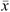
Two color-PALM imaging of ZapA-FtsZ, ZapB-FtsZ and ZapA-ZapA pairs.Cropped PALM images of cells expressing Dronpa-ZapA and FtsZ-PAmCherry1 (Ai-vi), ZapB-Dronpa and FtsZ-PAmCherry1 (Bi-vi), or Dronpa-ZapA and PAmCherry1-ZapA (Ci-v). Approximate cell outlines are indicated in yellow dashed lines. (Cvi) 2C-PALM image of a 100 nm TetraSpeck bead. (D) Histograms of the apparent displacement between the given protein pairs in individual cells. The mean values for the ZapA-FtsZ, ZapB-FtsZ and ZapA-ZapA pairs are 55 ± 50 nm (n = 158), 97 ± 70 nm (n = 132) and 33 ± 33 nm (n = 39), respectively (x- ± sd). (E) The diameters for ZapB-Dronpa and FtsZ-PAmCherry1 structures visualized simultaneously in the same cell (blue circles) were best fit to a line (red) where y = 1.0x - 95. The R2 of the fitted line to the data was 0.89. Scale Bars, as labeled in nm.